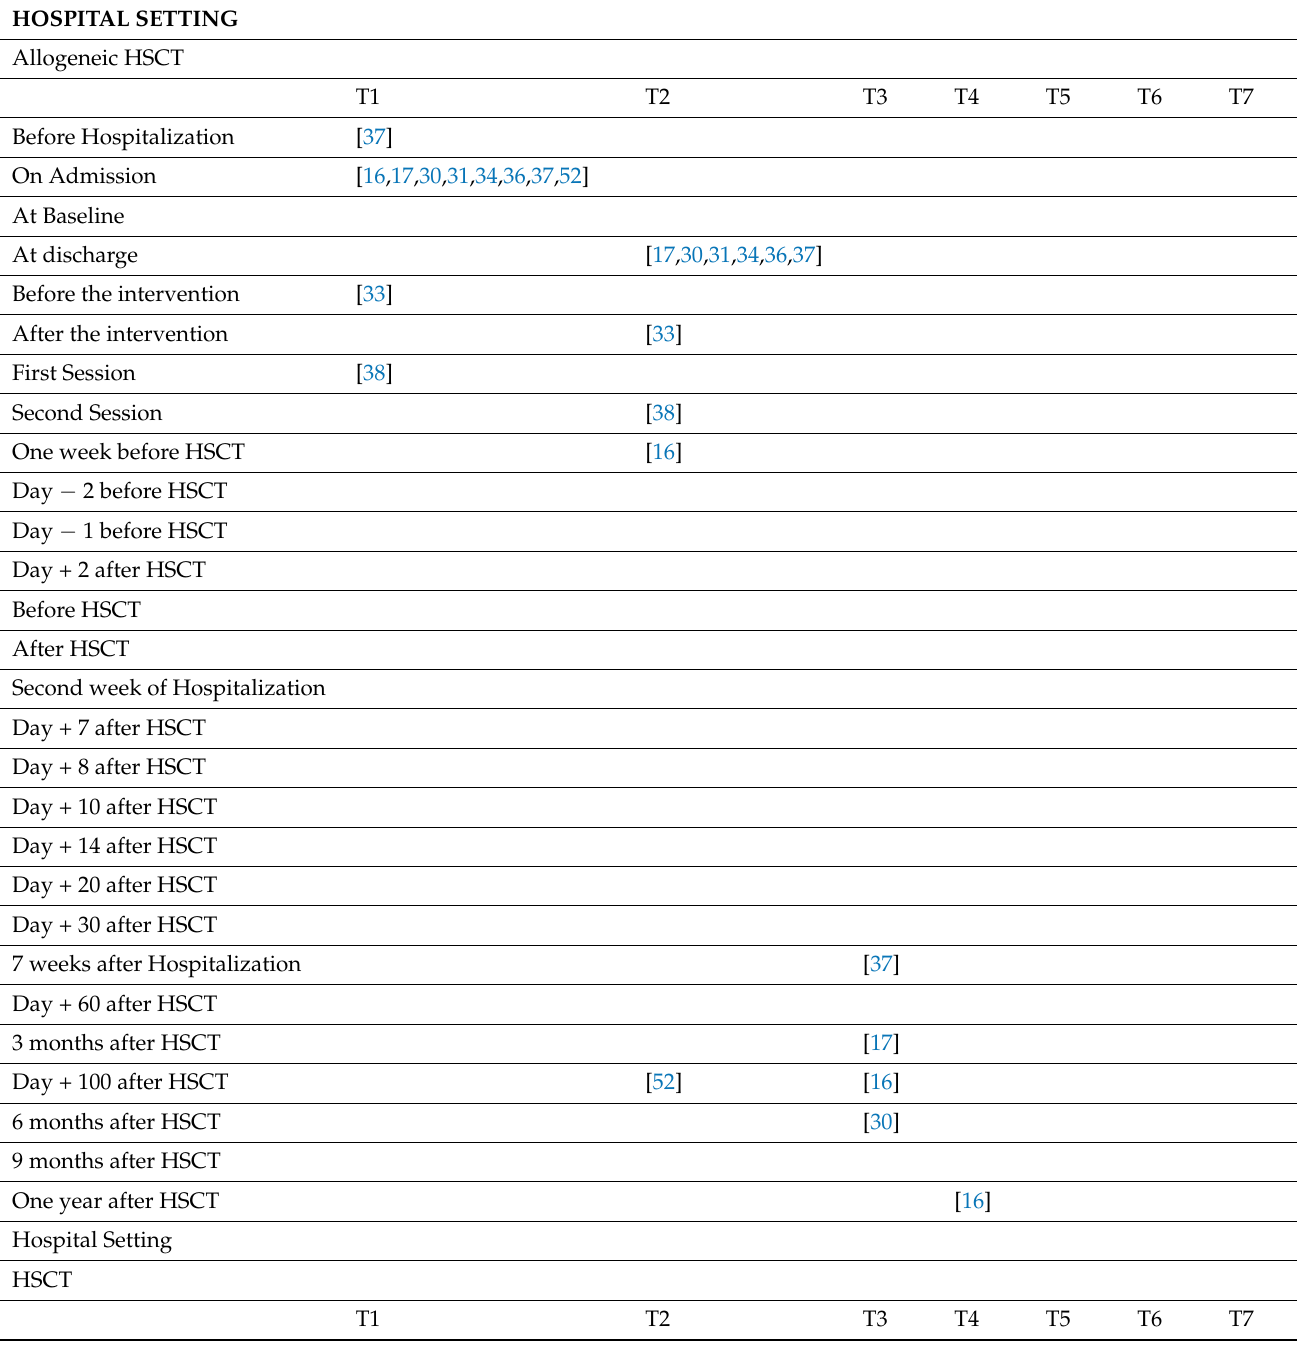
Table 3. Timing of